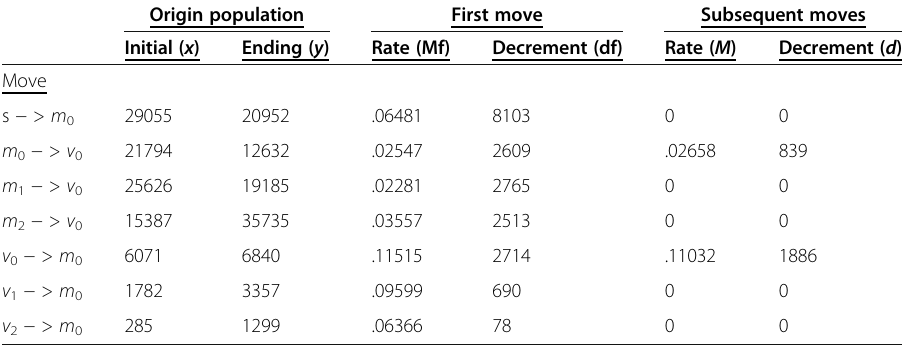
Table 5 First (Mf) and subsequent (M) movement rates and decrements (df and d ) in the 7 state- duration model, United States Females, 2000 – 2005, ages 30 to 35 Origin